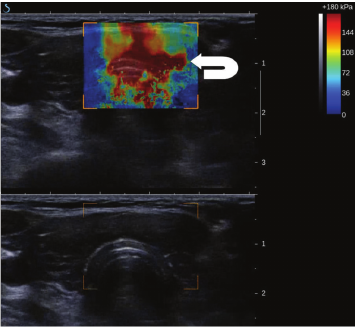
Figure 5: An artifact (arrow) from tissue compression on elas- togram (upper image) in patient with Hashimoto thyroiditis, with no real focal lesions evident on B-mode ultrasound (lower image). A hard sti ff pseudolesion is generated (see also Supplementary material 1 available online on doi: 10.1155/2012/657147). To avoid such artifacts no pressure on the probe during elasticity evaluation should be applied.